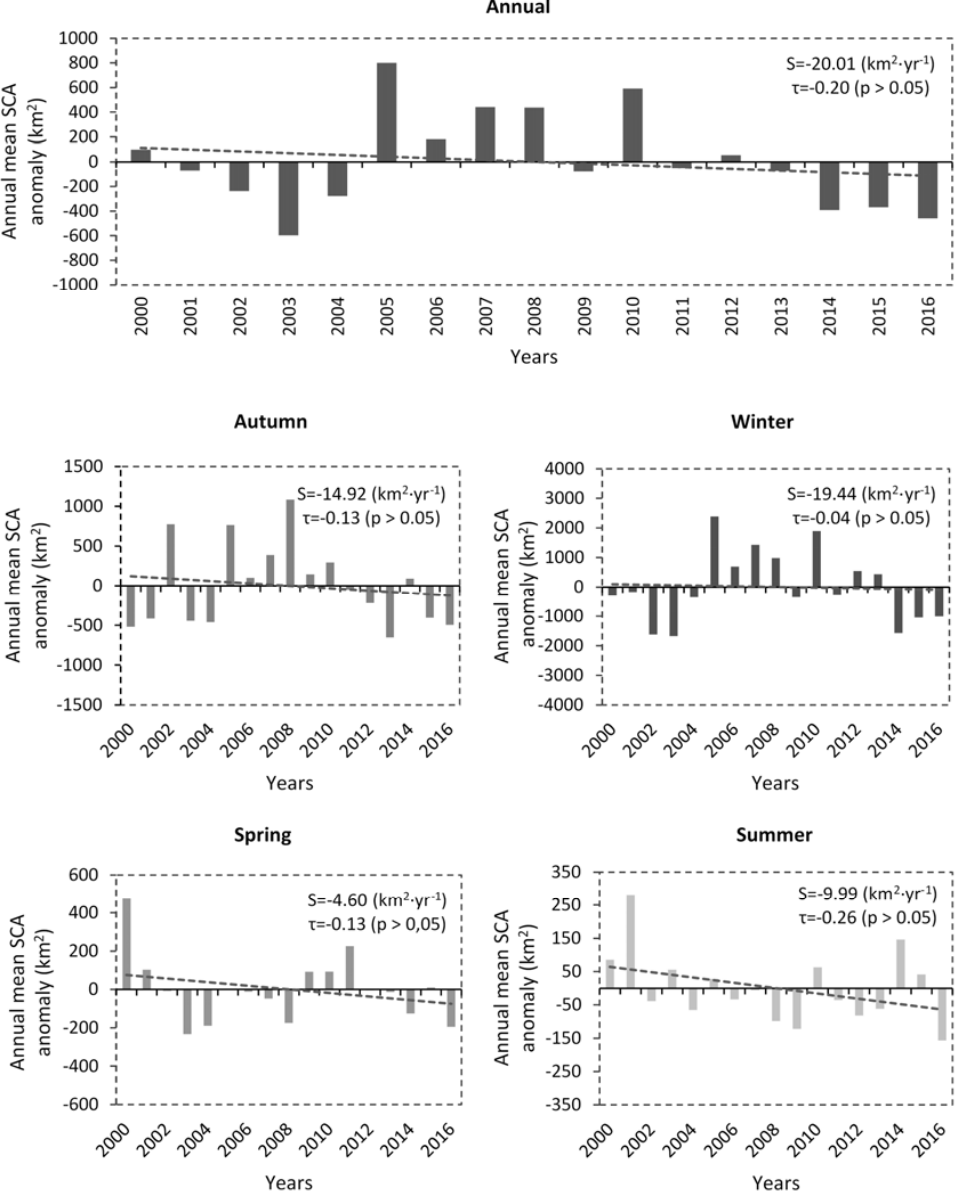
Figure 6. Anomalies of annual and seasonal mean SCA for the 2000–2016 period. Mann–Kendall’s trend test “ τ ” and Sen’s slope estimator “S”.